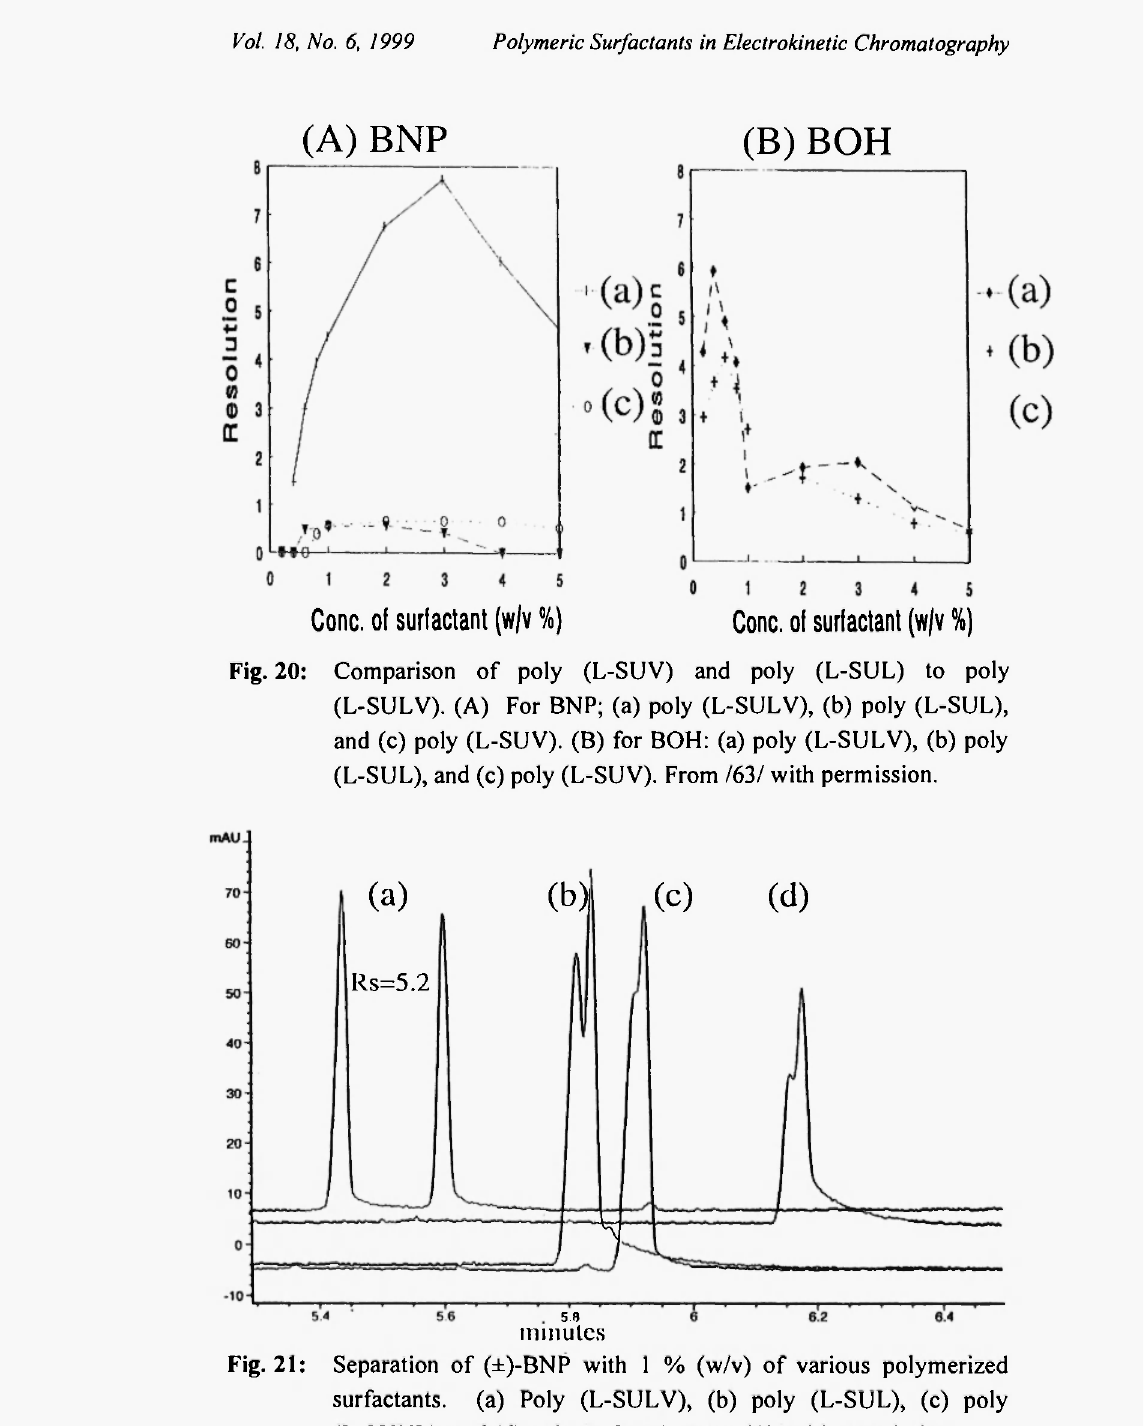
Fig. 21: Separation of (±)-BNP with 1 % (w/v) of various polymerized surfactants, (a) Poly (L-SULV), (b) poly (L-SUL), (c) poly (L-SUVL), and (d) poly (L-SUV). From 763/ with permission.